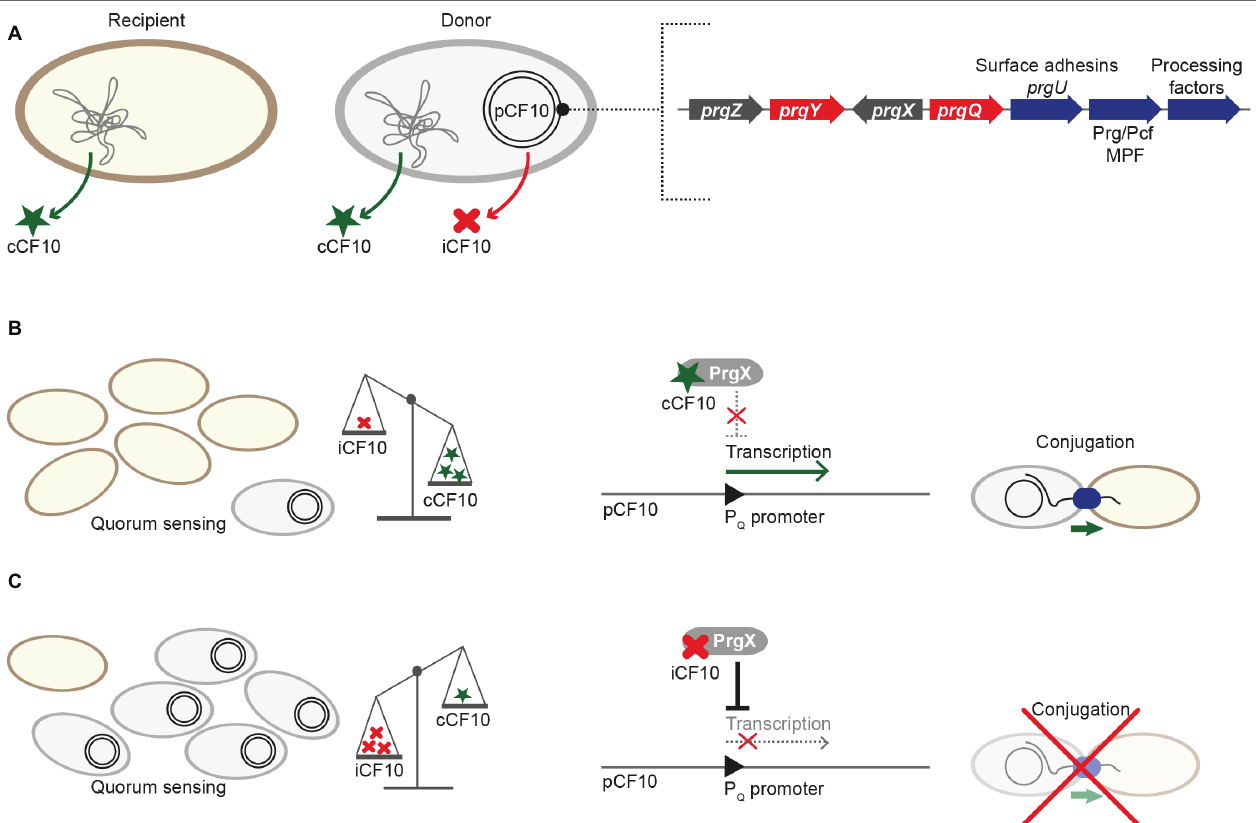
FIGURE 2 | Regulation of pCF10 conjugative transfer. (A) While both recipient and donor cell produce the pheromone cCF10 from ccfA on the chromosome, only cells harboring pCF10 secrete the inhibitor iCF10 that is produced from prgQ . prgQ lies upstream of the three cassettes responsible for conjugative transfer: The first cassette codes for the surface adhesins PrgA, PrgB, and PrgC and the regulator PrgU, the second harbors members of the Prg/Pcf conjugation system, and the third is composed of genes for processing factors (including the relaxase). The RRNPP-family protein PrgX is the master regulator and PrgY aids in reducing cCF10 pheromone activity. prgZ codes for a permease that imports both cCF10 and iCF10. (B) The relative ratio between cCF10 and iCF10 increases with a higher proportion of potential recipients present. This leads to increased import of cCF10, which binds to PrgX, thus interfering with its ability to repress the P Q